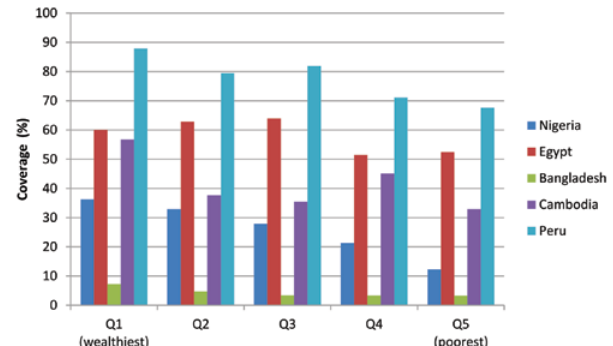
Figure 4 Community case management (CCM) coverage estimates by wealth quintiles in exemplar